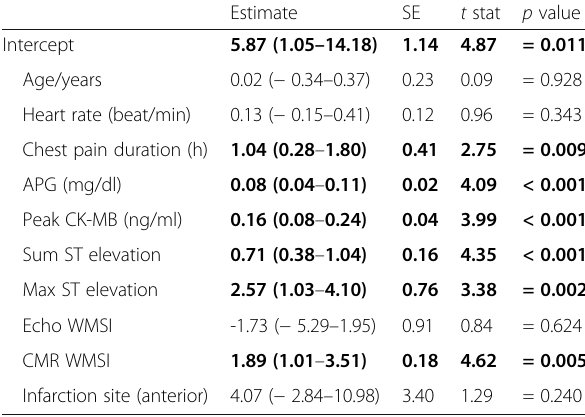
Table 4 The multivariate linear regression analysis of the factors affecting